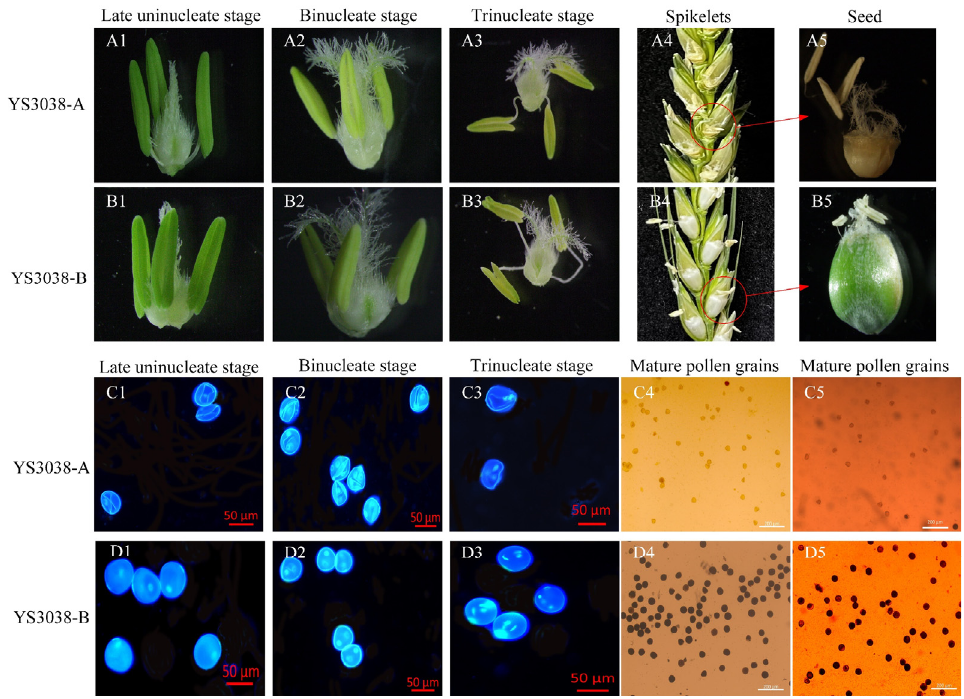
Figure 1. Phenotypic and cytological observations. ( A1 – A5 , B1 – B5 ) Anther structure, the morphology of the seed status on spikelets and the seed status in YS3038. ( C1 – C5 , D1 – D5 ) Microspores DAPI staining of microspores, I 2 -KI and peroxidase staining of mature pollen grains. ( A1 , B1 , C1 , D1 ), Late uninucleate stages. ( A2 , B2 , C2 , D2 ), Binucleate stages. ( A3 , B3 , C3 , D3 ), Trinucleate stage. Scale bars = 50 µm ( C1 – C3 , D1 – D3 ), 200 µm ( C4 , C5 , D4 , D5 ).